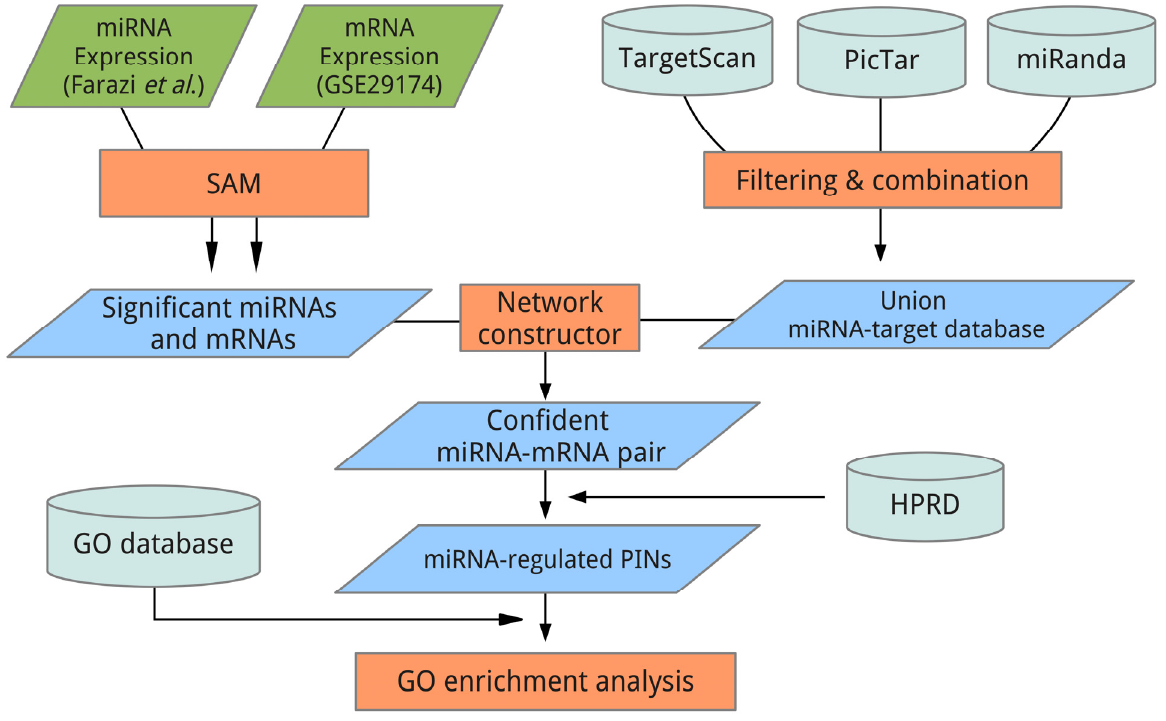
Figure 1. Analysis flow chart used in this work. After expression profiles and target prediction databases were fetched and preprocessed, they were subjected to the analysis process described here and in the “Experimental